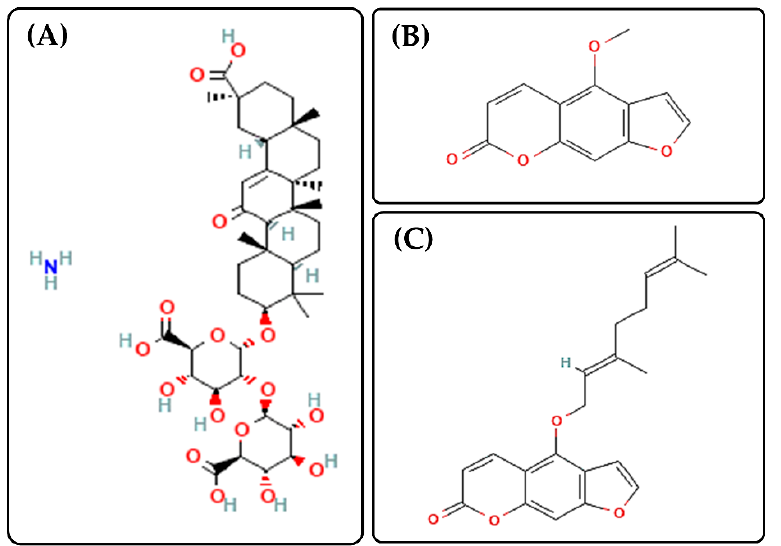
Figure 1. Chemical structures of ammonium glycyrrhizinate (AG, Panel ( A ), https://pubchem.ncbi.nlm.nih.gov/compound/62074#section=2D-Structure, accessed on 13 April 2022), Bergapten (Panel ( B ), https://pubchem.ncbi.nlm.nih.gov/compound/2355#section=2D-Structure, accessed on 13 April 2022) and Bergamottin (Panel ( C ), https://pubchem.ncbi.nlm.nih.gov/compound/5471349#section=2D-Structure, accessed on 13 April